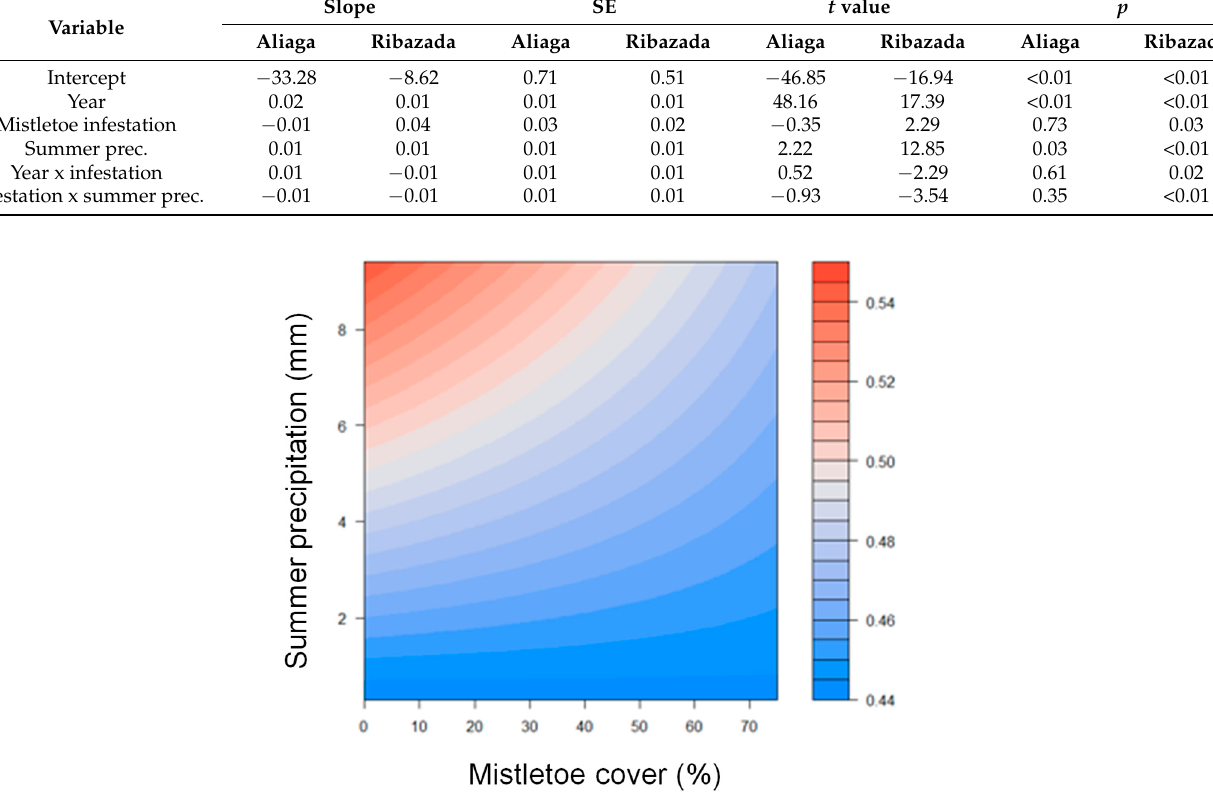
Figure 7. Interactive effects of mistletoe infestation or cover and summer precipitation (log-transformed values) on radial growth (color scale, log-transformed basal area increment) of junipers as predicted by the linear mixed-effects models fitted to data from the Ribazada site.